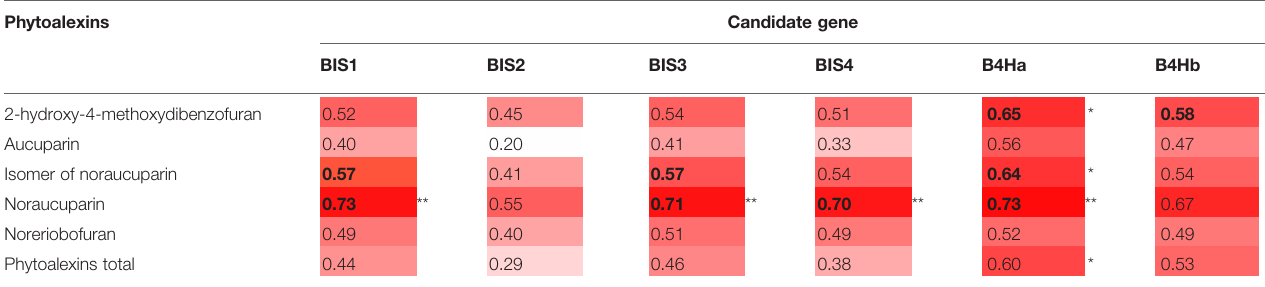
TABLE 4 | Pearson's correlation between changes in the expression of the six CGs of the phytoalexin biosynthesis pathway (expressed as fold changes) and the amounts of individual phytoalexins, p < 0.05 (*) and p < 0.01 (**). Intensity of red shading visualizes strength of correlation. Signi fi cant correlations are given in bold.